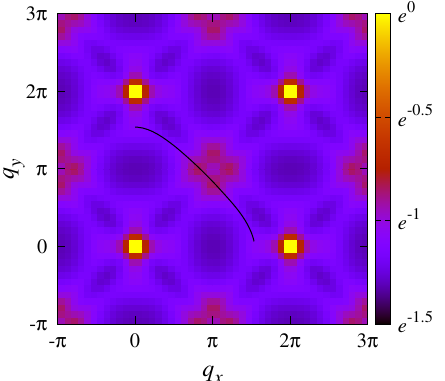
FIG. 14. The intensity distribution of fermion spin susceptibil- h ¼ h ; T ¼ 0 . 05 ; q ; ω 0 Þ with L ¼ 24 . To amplify the ity χ c n ¼ F ð weak signal of the soft mode, we have fixed the intensity range to be less than unity and taken a logarithm of the original data. The black line shows the location of 2 k F for the noninteracting FS, only a quarter of which are plotted